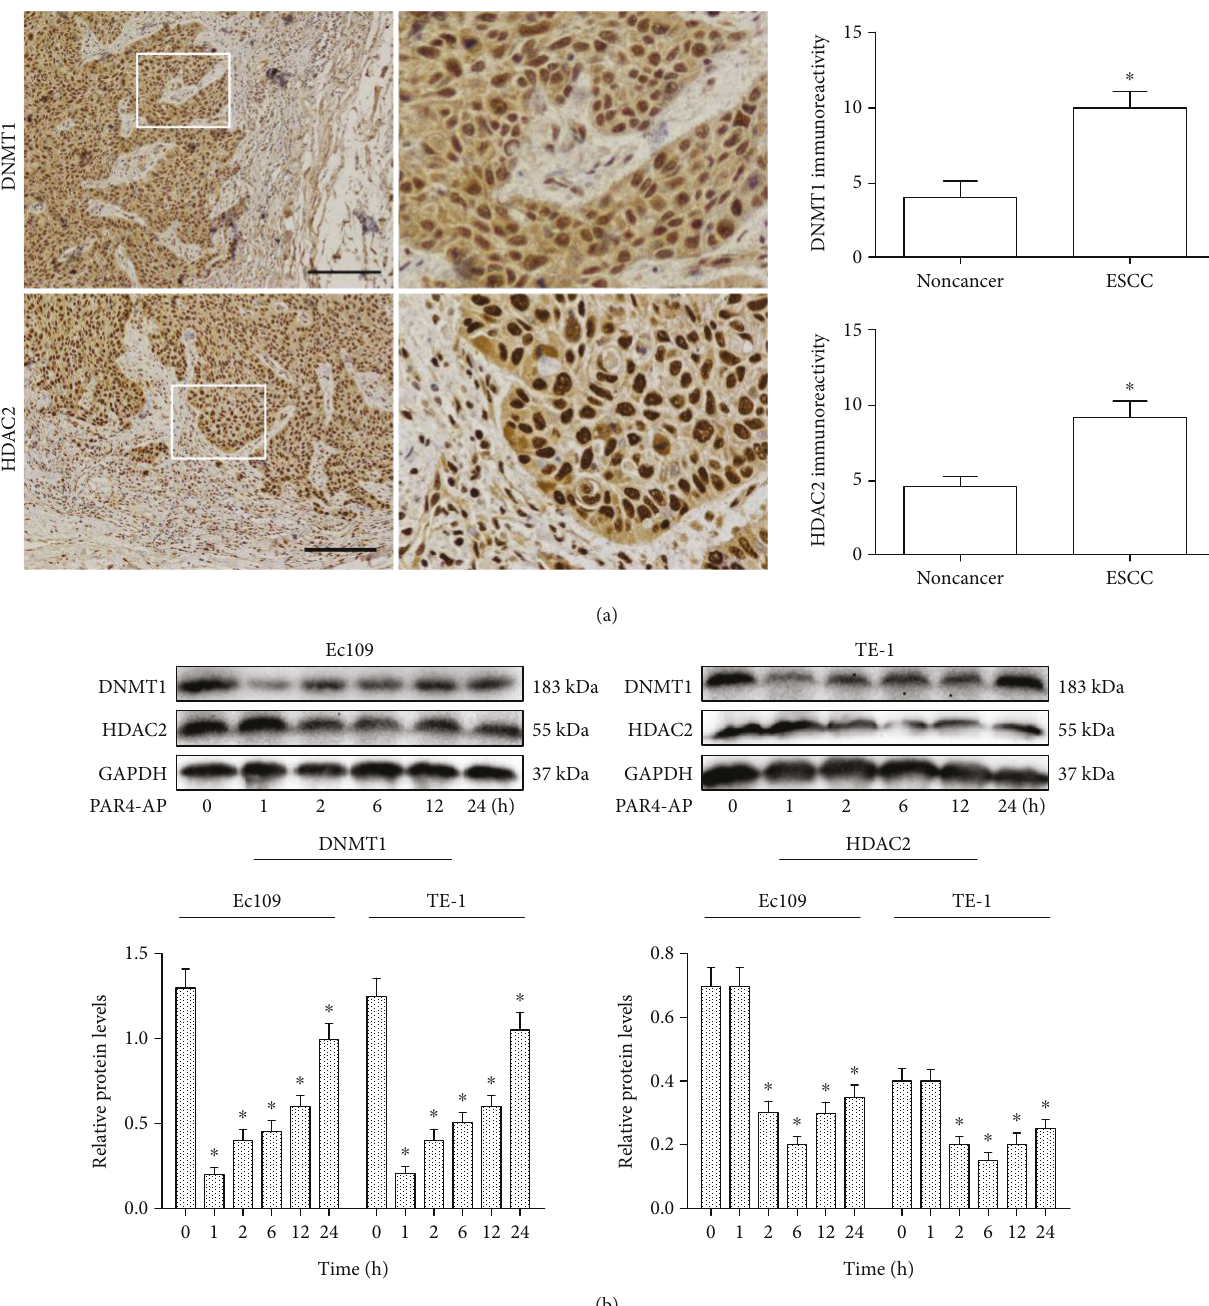
Figure 1: Immunohistochemical staining for DNMT1 and HDAC2 in ESCC tissues and e ff ects of PAR4-AP on their expressions in ESCC cell lines after PAR4-AP treatment. (a) Representative immunostaining for DNMT1 and HDAC2 in ESCC tissues and adjacent noncancerous tissues. Sections were counterstained with hematoxylin. Scale bar: 100 μ m. Graphs showing DNMT1 and HDAC2 immunostaining in ESCC tissues and adjacent noncancerous tissues. The data are expressed as the mean ± SEM. ∗ P < 0 01 (Student ’ s t -test). Immunoreactivity was calculated by multiplying the percentage and intensity scores. (b) Examples of Western blotting showing DNMT1 and HDAC2 expressions in ESCC cell lines (EC109 and TE-1) with PAR4-AP treatment at 0, 1, 2, 6, 12, and 24h, respectively. The mean optic densities of the proteins were calculated by normalizing to GAPDH. The data are presented as the mean ± SEM ( n = 3 ), ∗ P < 0 05 versus (Figure 4(a)). The PAR4 gene knockdown was able to upregulate the levels of DNMT1 and HDAC2 proteins and genes and suppress p16 protein and gene expression following transfection of PAR4-siRNA with ESCC cells ( P > 0 05 ) (Figures 4(a) and 4(b)).